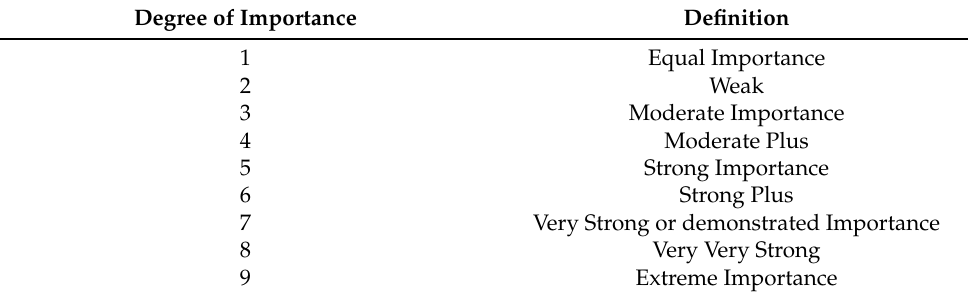
Table 4. Degree of priority